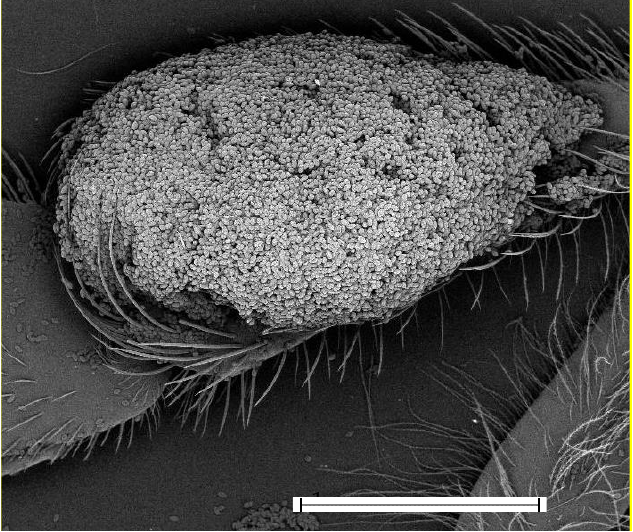
Figure 2. Example of a hindleg of a worker bee with packed pollen ready for the scanning electron microscope / energy dispersive X-ray (SEM/EDX) analysis. Bar = 1 mm.